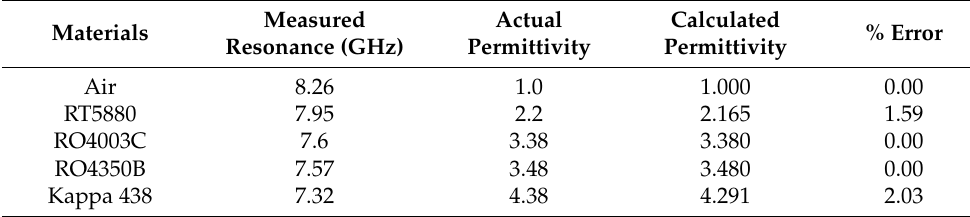
Table 1. Error analysis of calculated and actual